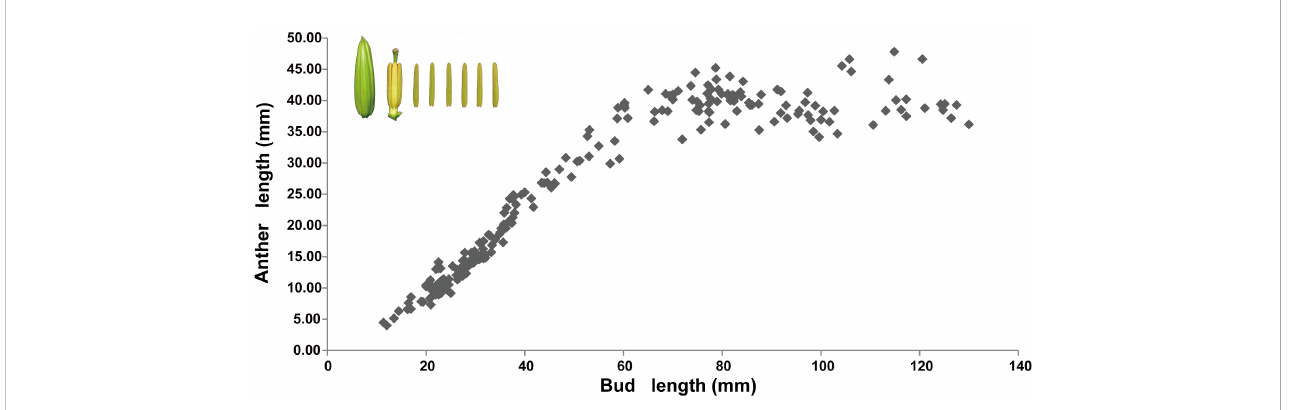
FIGURE 1 Relationship between anther length and fl ower bud length in Lilium Oriental Hybrid ‘ Siberia ’ . In the upper left corner are images of the lily bud and anther. Each point represents the average length of six anthers. The abscissa is bud length, and the ordinate is anther